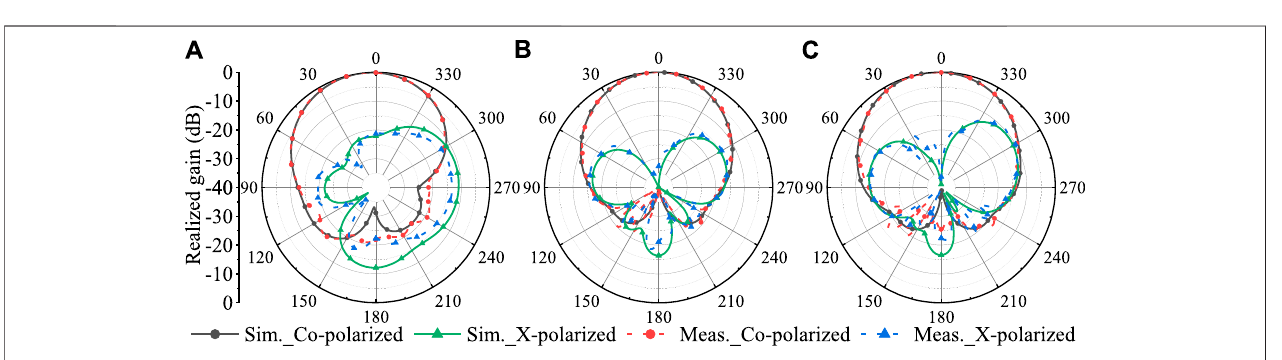
FIGURE 15 | Simulated and measured radiation patterns at the horizontal plane for (A) 2.4 GHz, (B) 5.2 GHz, and (C) 5.8 GHz.